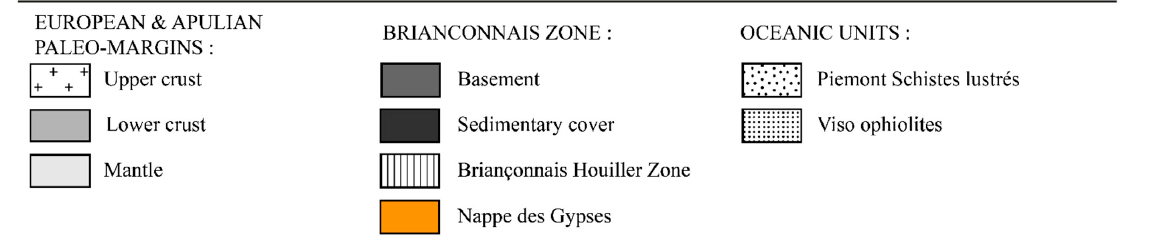
Figure 13. Possible kinematic reconstruction of this part of the Western Alps from Eocene to Oligocene modified after Lanari et al. [29] with associated P-T paths for Ambin basement and Vanoise cover [36], Vanoise basement, and Modane-Aussois units [34], “Nappe des Gypses” [25] Briançonnais Houiller Zone [29], and the PN-MP Pb-Ag deposits (this study). Geothermal gradients of 8 °C/km (a), 15 °C/km (b), and 40 °C/km (c) are also shown.